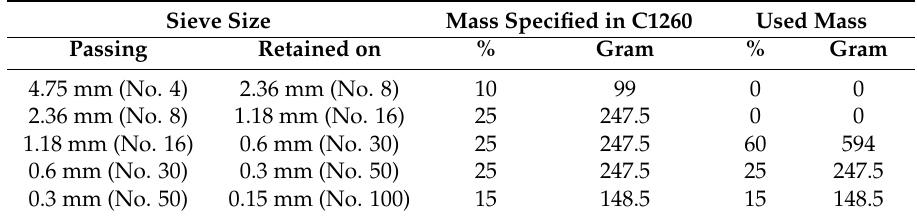
Table 3. Grading of aggregate specified in ASTM C1260 and used in the